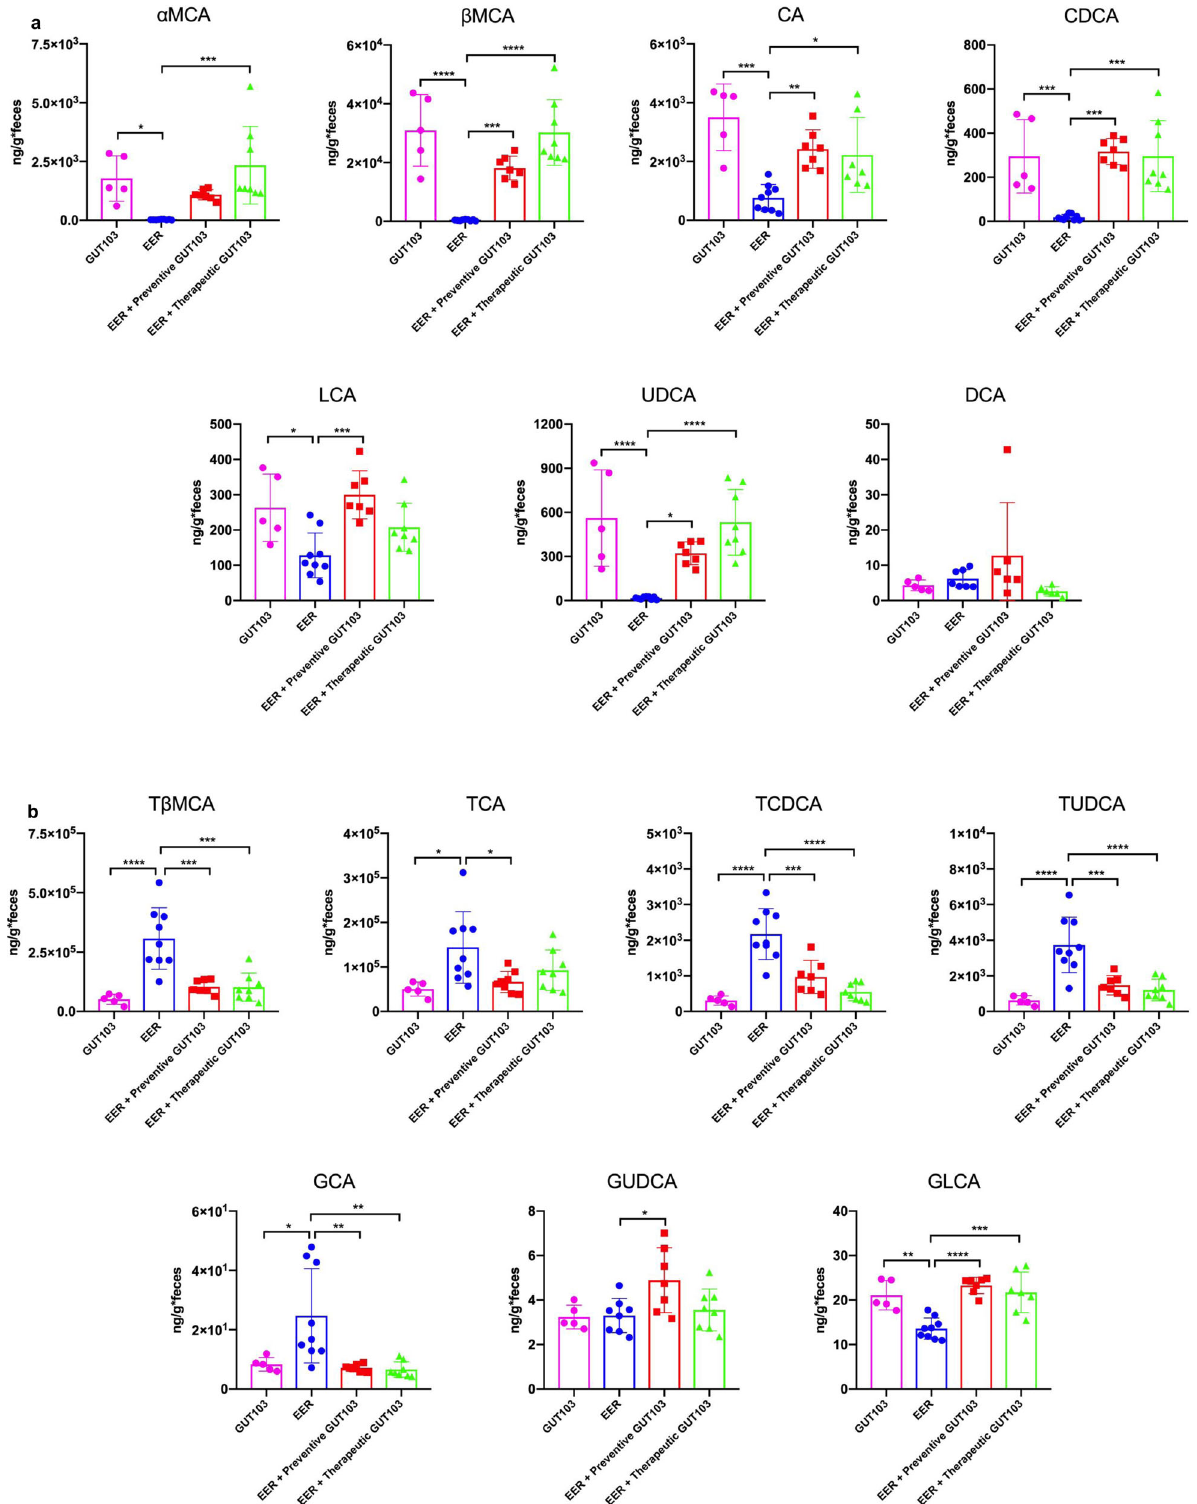
Fig. 2 Levels of unconjugated and conjugated bile acids in the cecal content of Il10 − / − mice at the time of sacri fi ce where experimental colitis was induced by inoculation with Escherichia coli LF82 (E), Enterococcus faecalis OG1RF (E), and Ruminococcus gnavus ATCC29149 (R). Gnotobiotic Il10 − / − mice were inoculated with GUT-103 ( N = 5), EER ( N = 9), GUT-103 plus EER (preventive protocol) ( N = 7), and EER plus GUT-103 (therapeutic protocol) ( N = 7). Il10 − / − mice were inoculated via gavage with GUT-103 (2 × 10 + 7 cfu/strain) or EER (2 × 10 + 7 cfu/strain). a Unconjugated bile acids: α MCA α -muricholic acid, β MCA β -muricholic acid, CA cholic acid, CDCA chenodeoxycholic acid, LCA lithocholic acid, UDCA ursodeoxycholic acid, DCA deoxycholic acid. b Conjugated bile acids: T β MCA taurine-conjugated β -muricholic acid, TCA taurocholic acid, TCDCA taurochenodeoxycholic acid, TUDCA tauroursodeoxycholic acid, GUDCA glycoursodeoxycholic acid, GCA glycine-conjugated cholic acid, GLCA glycine-conjugated lithocholic acid. 1e-way ANOVA, Mean ± SE, * P < 0.05, ** P < 0.01, *** P < 0.005, **** P < 0.001. Source data and calculated P -values are provided as a Source Data fi le. NATURE COMMUNICATIONS| (2021) 12:3105 |https://doi.org/10.1038/s41467-021-23460-x|www.nature.com/naturecommunications